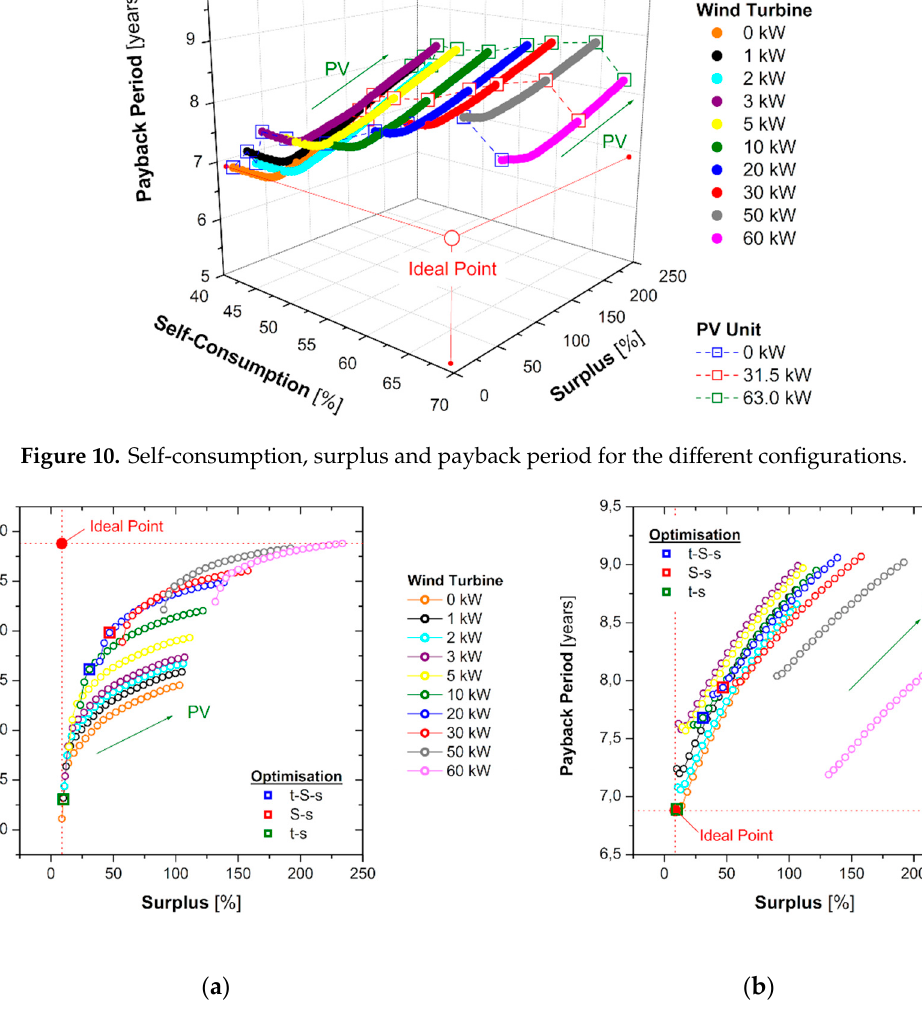
Figure 11. Self-consumption vs. surplus ( a ) and surplus vs. payback period ( b ) for the different configurations.